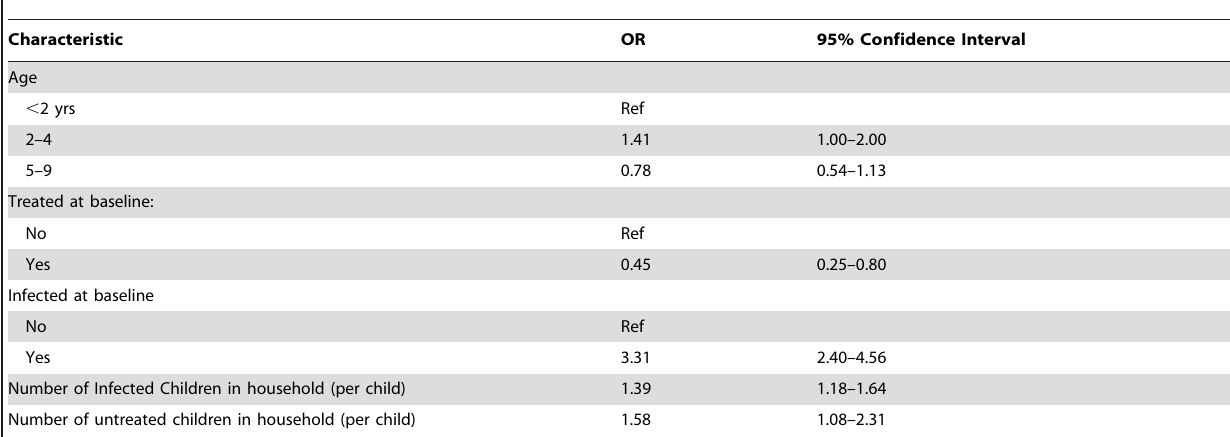
Table 5. Multivariate logistic regression model predicting infection at 6